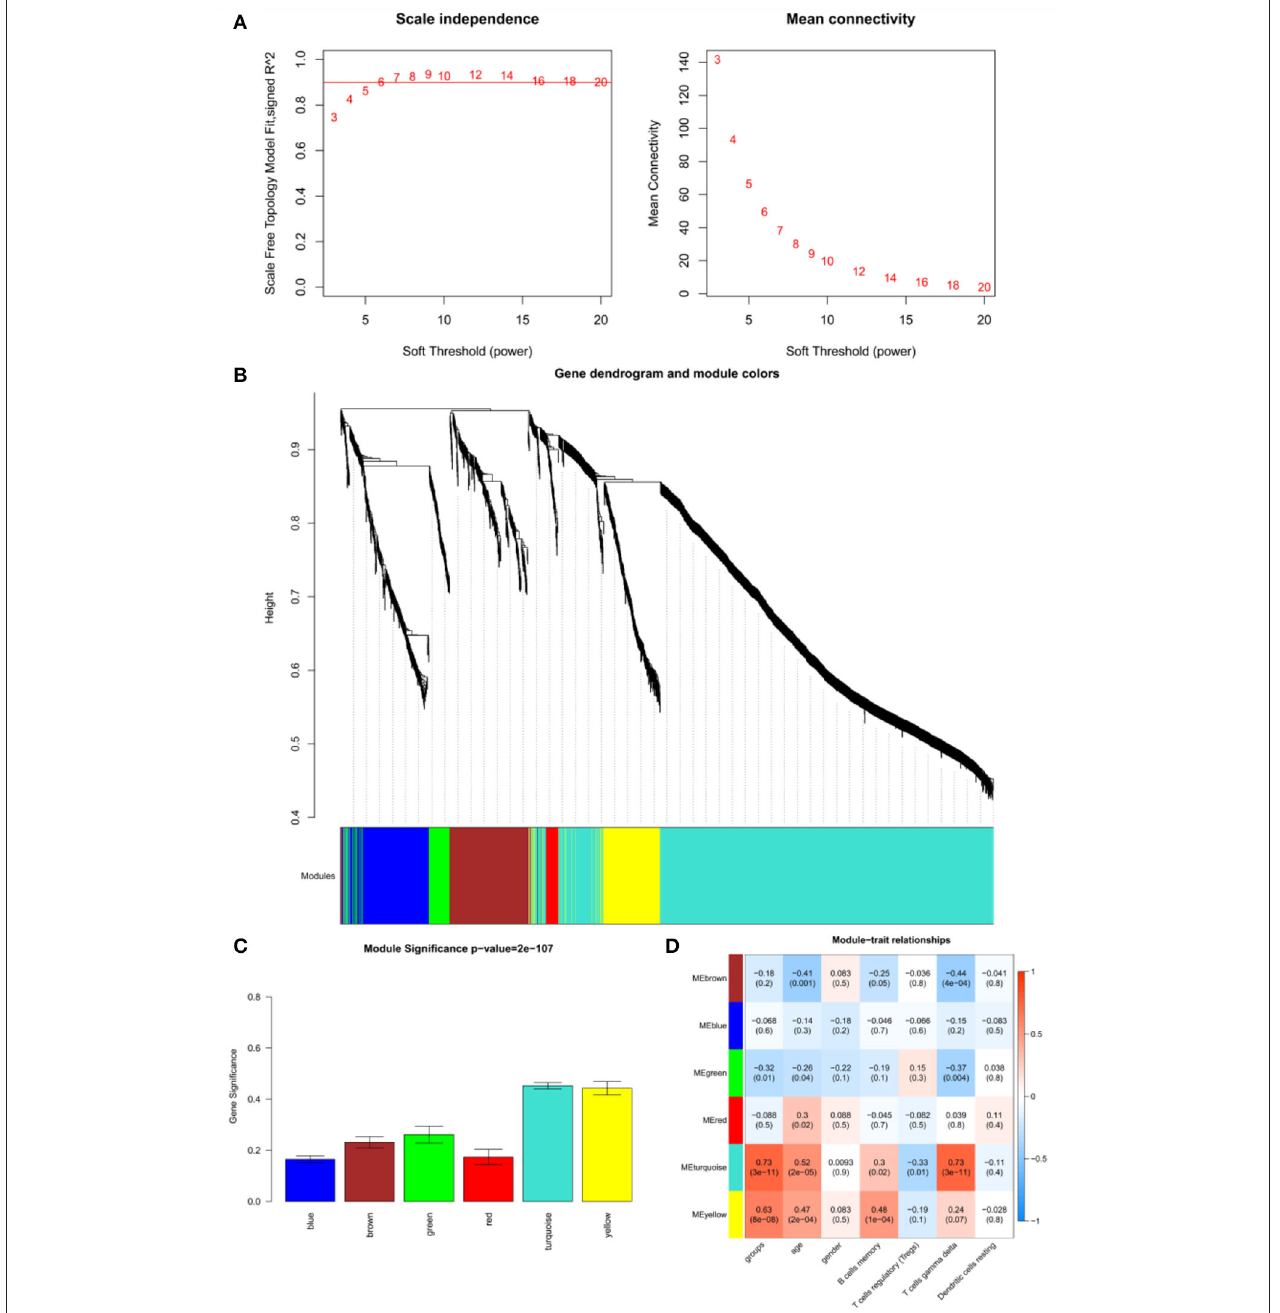
FIGURE 3 | Results of weighted gene co-expression network analysis (WGCNA). (A) Determination of the soft threshold for adjacency matrix. The horizontal axis represents the soft threshold power, and the vertical axis represents the square of the correlation coefficient of log 2 k and log 2 p(k). The red line indicates the location when the correlation coefficient is 0.9, and the corresponding soft threshold power is 6. (B) Gene dendrogram derived from hierarchical clustering. The different modules are indicated by colors underneath the dendrogram. (C) Correlations between modules and diseases. The horizontal axis represents modules, and the vertical axis represents the overall correlation coefficient between genes and disease states in the module. (D) Correlations between modules and traits. The upper figure in each row represents the correlation whereas the lower figure represents the P -value. Blue represents a negative correlation, and red represents a positive